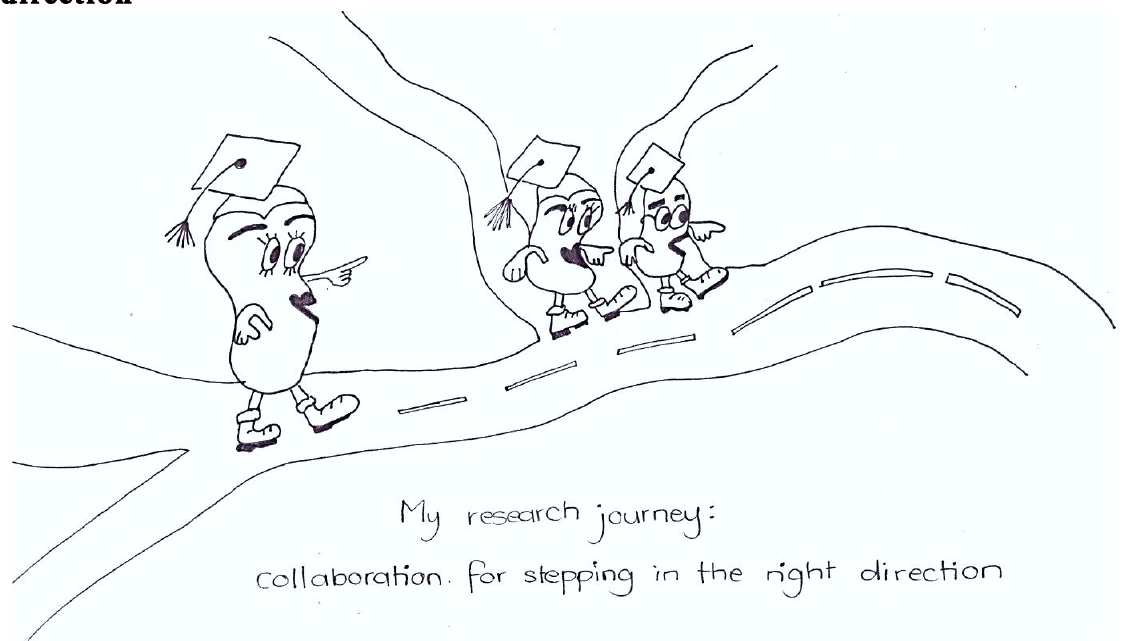
Figure 3: ‘My research journey: Collaboration for stepping in the right